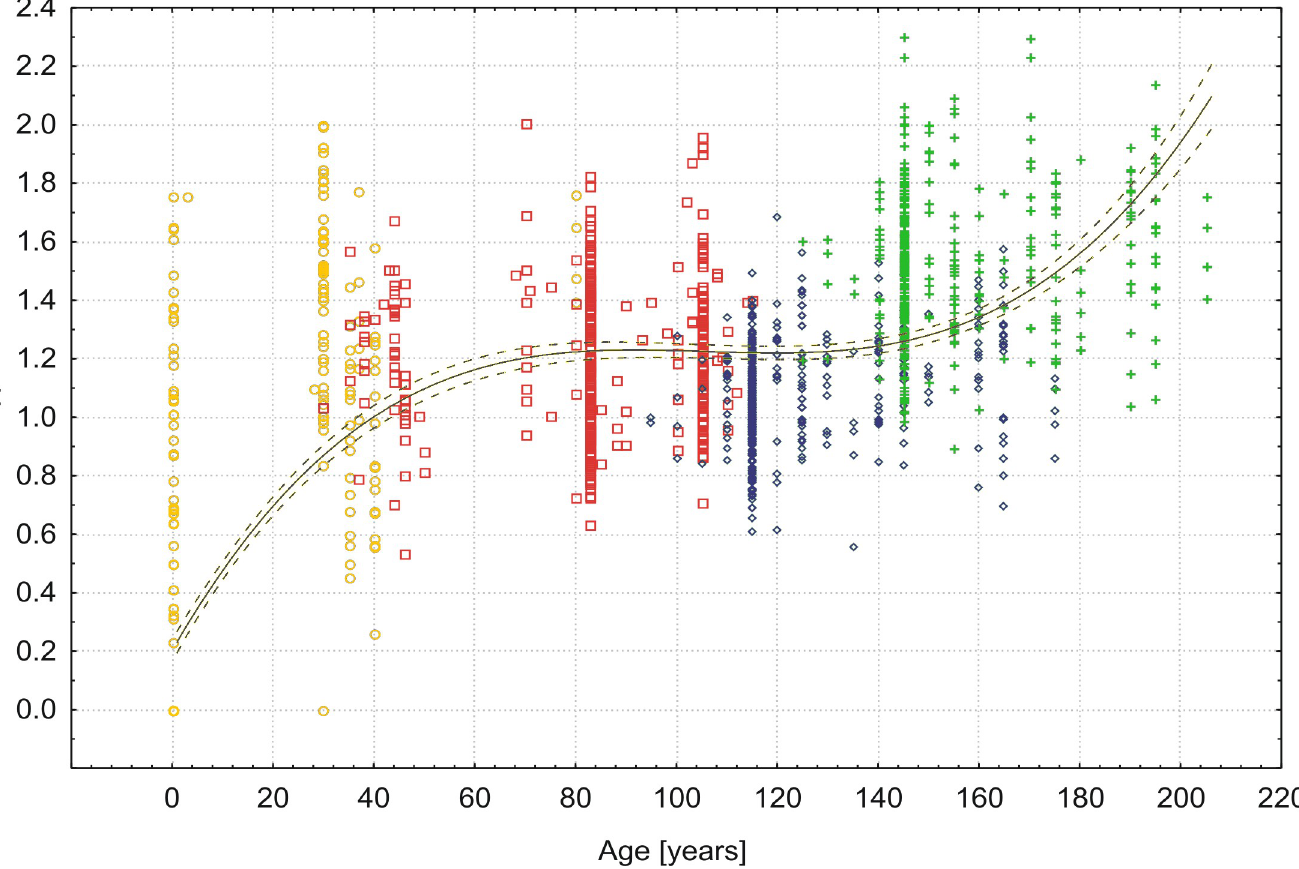
Fig 5. Relationship between vascular plant species diversity (H’: Shannon-Wiener index) and successional age in 100 m 2 plots. Fitted by 3 rd polynomial function (black solid line: r = 0.719; p < 0.001) with 95% confidence interval (black dashed lines). Symbol colors correspond to those used in Fig 1 for plots and years of